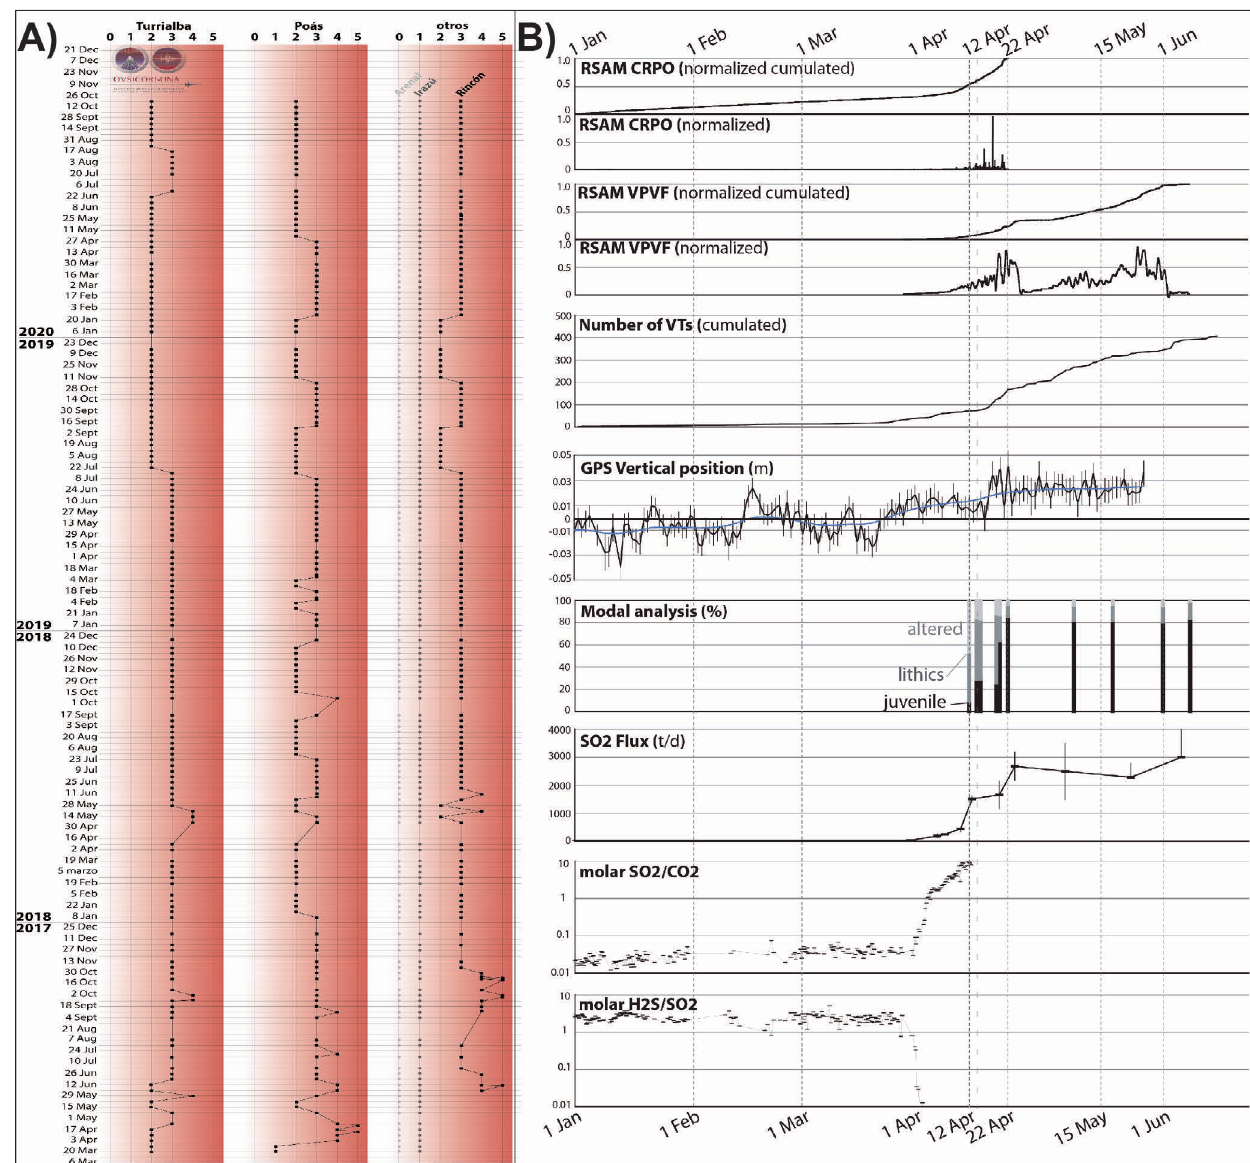
Figure 3: [A] Example of the activity level of the volcanoes over time updated weekly and as presented on the OVSICORI-UNA website. The activity level starts at 0 (dormant), goes to 3 (the volcano is considered in eruption), and to 5 as the maximum (intense ash emission, high seismicity, fast deformation and/or intense degassing). [B] Seismology, deformation, gas chemistry and petrology sequence for the 2017 eruptive crisis at Poás volcano as monitored by the OVSICORI-UNA.